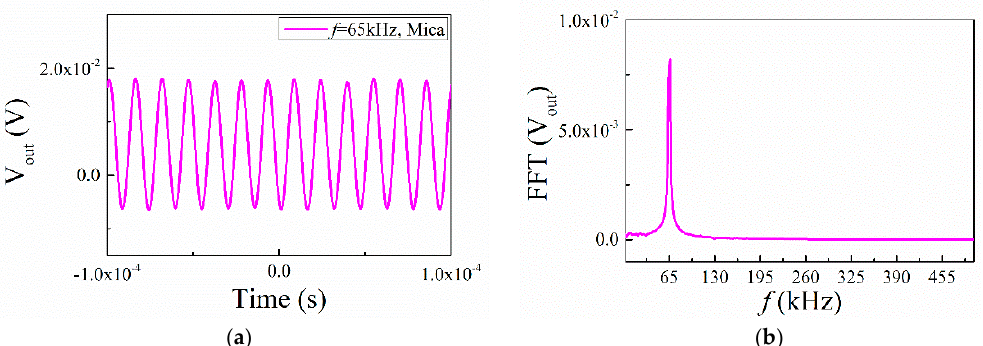
Figure 12. ( a ) Waveforms of ME voltage in the time domain for the ME structure with mica trestle at 65 kHz; ( b ) the FFT spectral pattern for ME voltage.